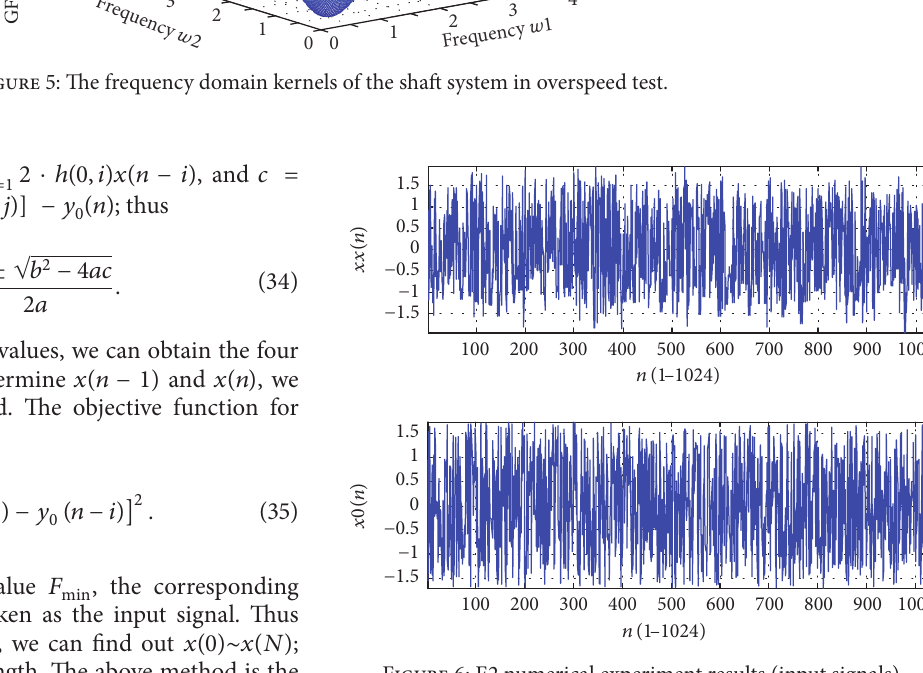
Figure 6: E2 numerical experiment results (input signals).